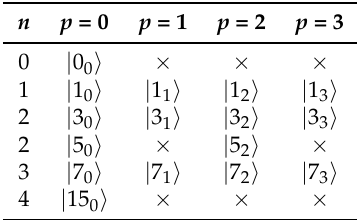
Table 1. Cyclic permutation eigenvectors with N = 4 agents. The first column shows the number of infected agents in the eigenvector. Each remaining column corresponds to a permutation sector p , and each row the corresponding state | µ p (cid:105) . The cross symbol indicates null-normed vector and the dimension of the vector space is d = 2 4 .